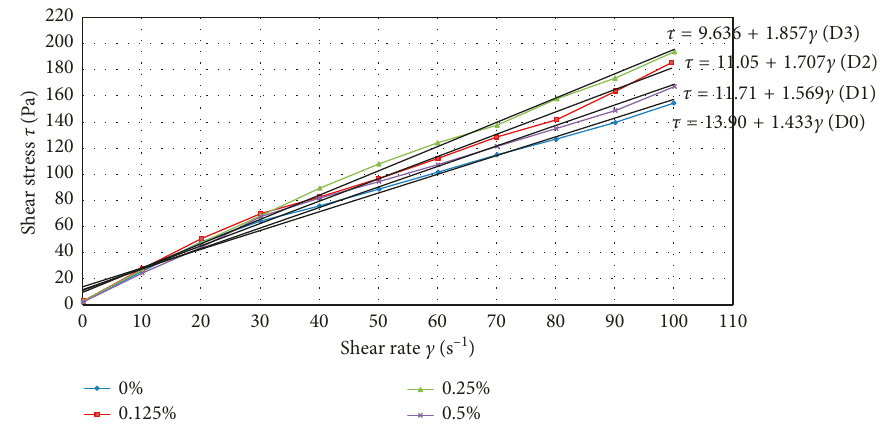
Figure 6: Flow curves of nanomodified cement pastes after 5min of mixing.